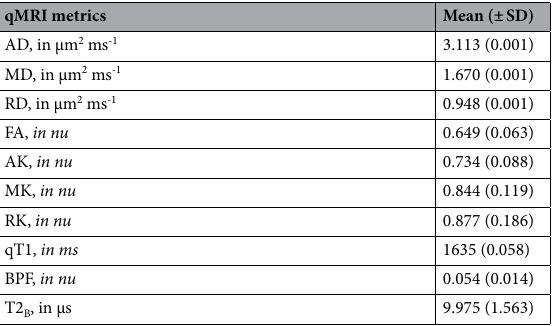
Table 1. Mean (± SD) values of the standard diffusion tensor (DTI) metrics axial/radial/mean diffusivity (AD/ RD/MD) and fractional anisotropy (FA), diffusion kurtosis imaging (DKI) metrics axial/radial/mean kurtosis (AK/RK/MK), quantitative magnetisation transfer (qMT) metrics bound pool fraction and bound pool transverse relaxation time (BPF/T2 B ) and quantitative longitudinal relaxation time (qT1), in the sciatic nerve of 12 healthy volunteers.